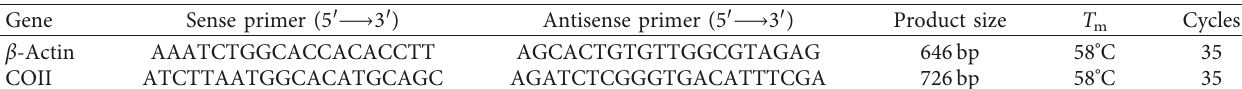
Table 1: Summary of the gene-specific PCR primer sequences, the length of amplificated product, the appropriate annealing temperature used in the experiments, and the number of the amplification